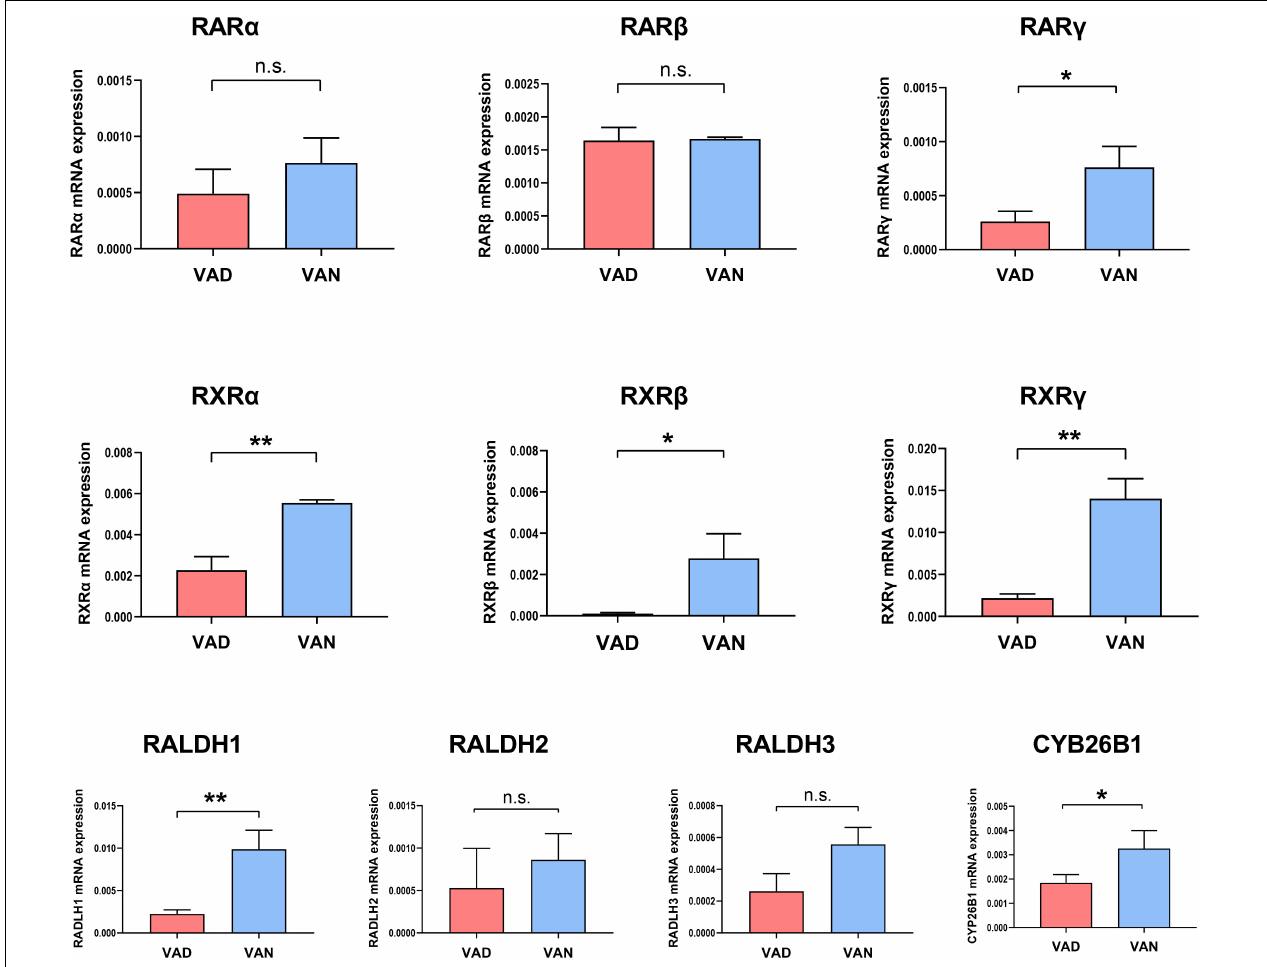
FIGURE 2 | Impact of consumption of the VAD-diet for 45 weeks on the mRNA expression of the vitamin A (VA)-related receptors and VA-related enzymes in the cortex of the APP/PS1 transgenic mice. The expression of retinoic acid receptors (RAR- α , RAR- β , and RAR- γ ), retinoid X receptors (RXR- α , RXR- β , and RXR- γ ), retinaldehyde dehydrogenases (RALDH1, RALDH2, and RALDH3), and CYP26B1 were determined by real-time quantitative PCR (RT-qPCR). VAD, vitamin A deficiency diet; VAN, vitamin A normal diet. n = 3 per group. ∗ P < 0.05, ∗∗ P < 0.01, and n.s., non-significant.